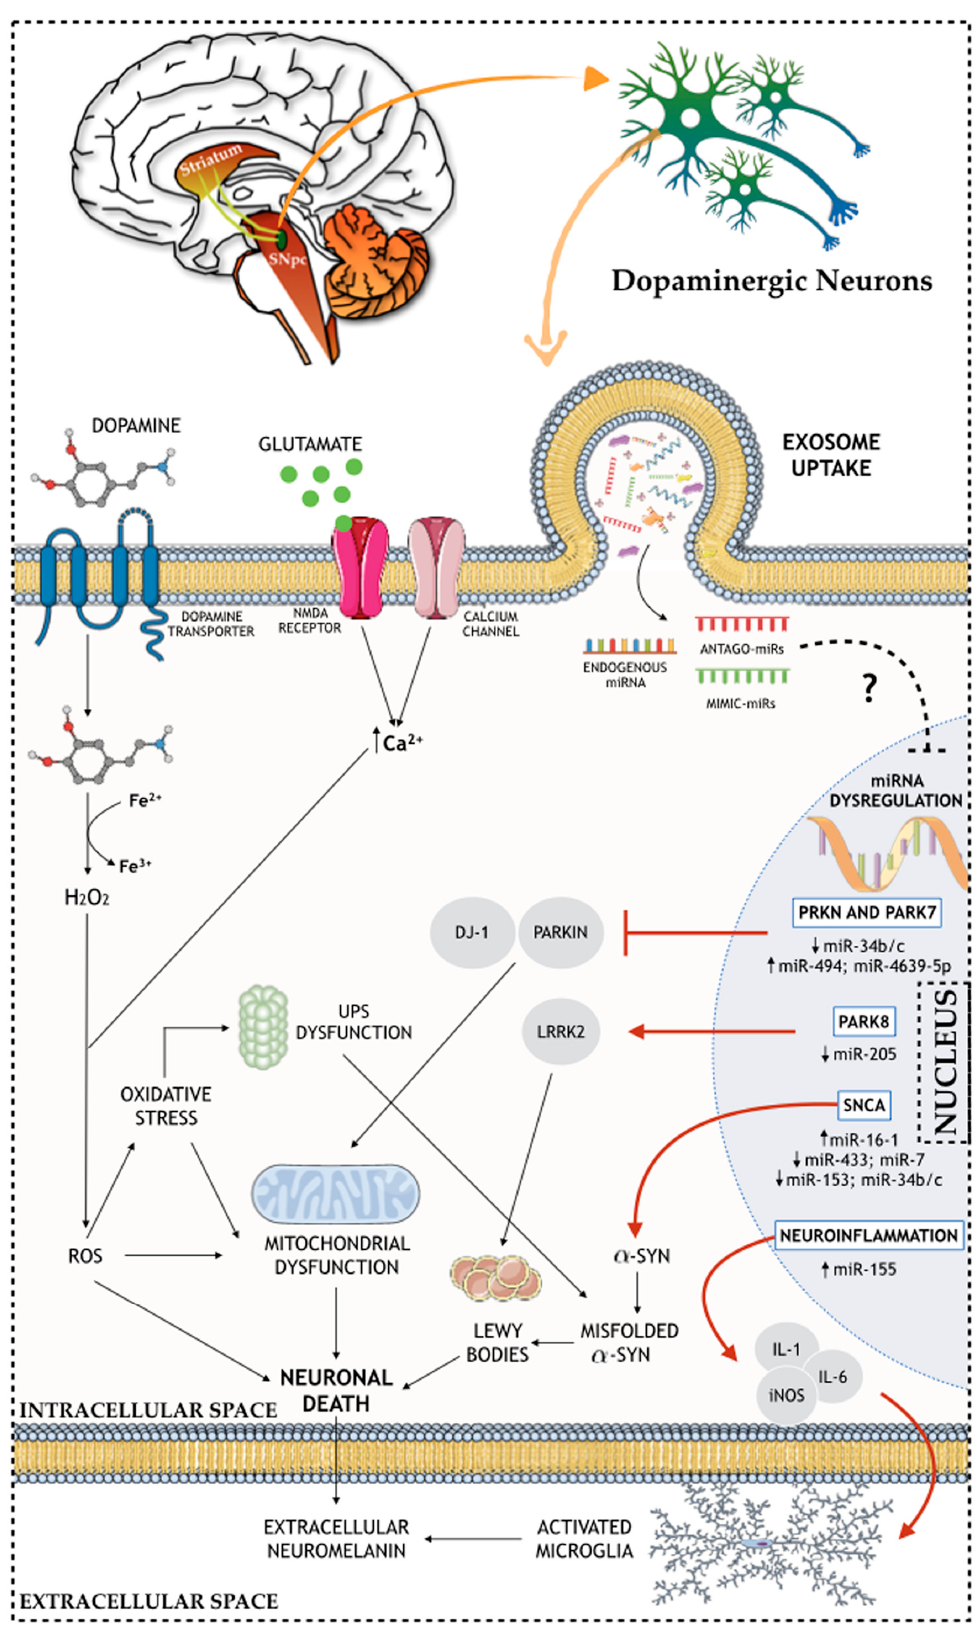
Figure 1. Schematic representation of the role of miRNAs in the molecular and cellular (e.g. nuclear, intracellular, and extracellular) mechanisms of PD